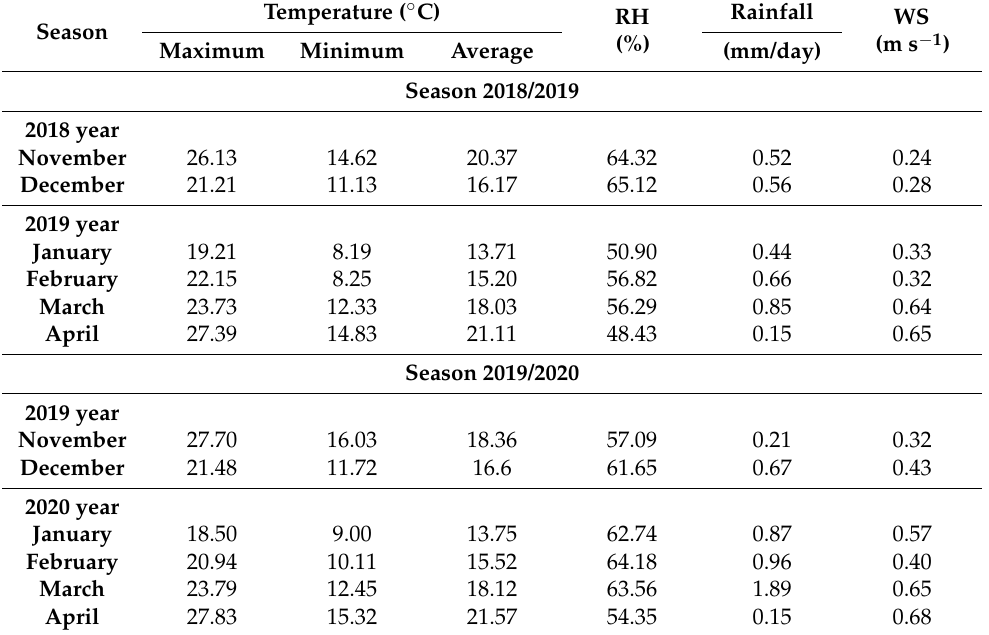
Table 1. Temperature, relative humidity (RH), rainfall, and wind speed (WS) of Cairo, Egypt, (30 ◦ 03 (cid:48) 12 (cid:48)(cid:48) N and 31 ◦ 19 (cid:48) 05.2 (cid:48)(cid:48) E) in the winter seasons of 2018/2019 and 2019/2020. Temperature ( ◦ C) RH Rainfall WS Season (%) Average